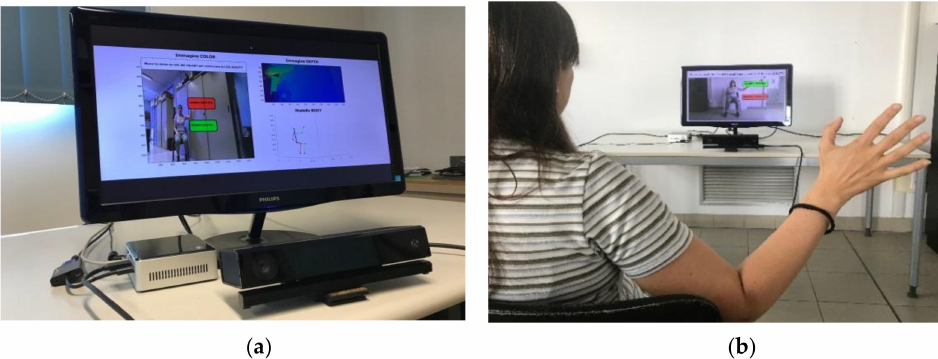
Figure 1. System for the lower limbs and postural tasks analysis: ( a ) RGB-Depth camera (Microsoft Kinect v2), NUC i7 Intel mini-PC and monitor ( b ) example of GUI with visual feedback.